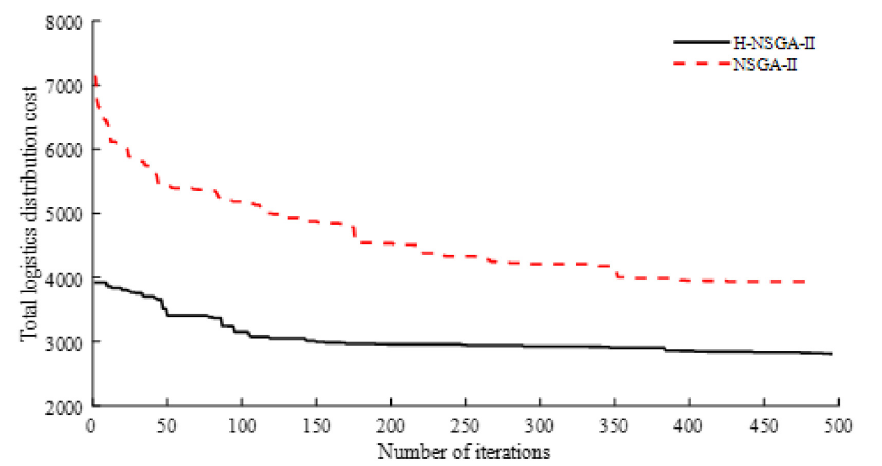
Fig 5. Comparison of convergence results of